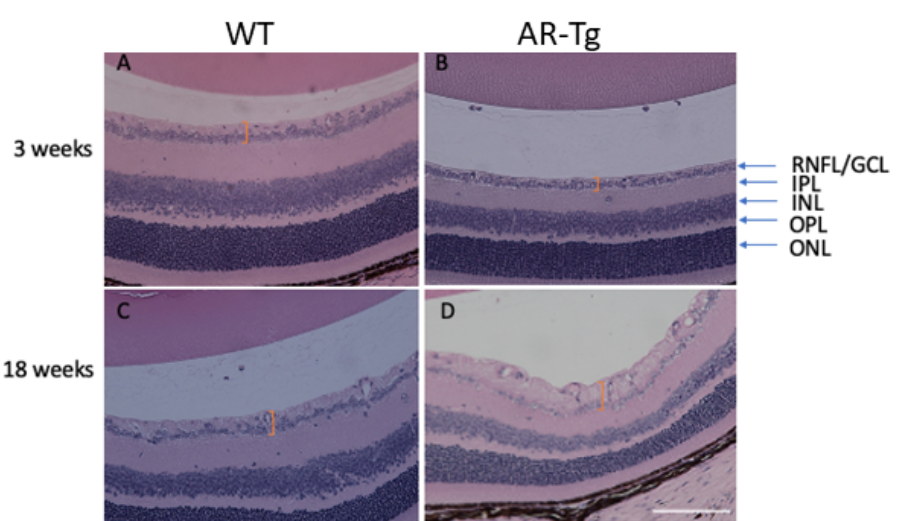
Figure 1. Age-dependent thickening of the retinal nerve fiber layer complex in AR-Tg mice. At 3 weeks of age, the retinas from WT mice ( A ) were qualitatively similar to retinas from AR-Tg mice ( B ). However, by 18 weeks of age, WT mouse retinas ( C ) were thinner at the nerve fiber layer/RGC layer as compared with AR-Tg retinas ( D ). Orange brackets demarcate the areas of comparison. Retinal layers are indicated with arrows: RNFL/GCL, retinal nuclear layer/ganglion cell layer complex; IPL, inner plexiform layer; INL, inner nuclear layer; OPL, outer plexiform layer; ONL, outer nuclear layer. Scale bar = 200 μ m.